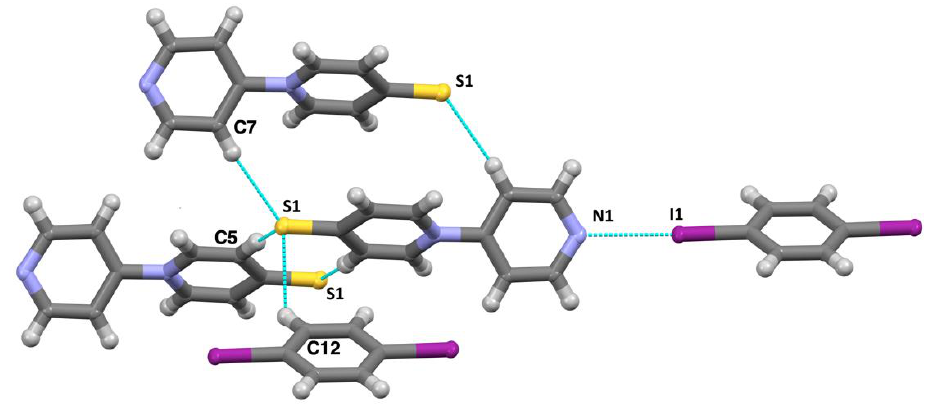
Figure 2. N ··· I XB and S ··· H contacts in 1 Figure 2. N … I XB and S … H contacts in 1 .